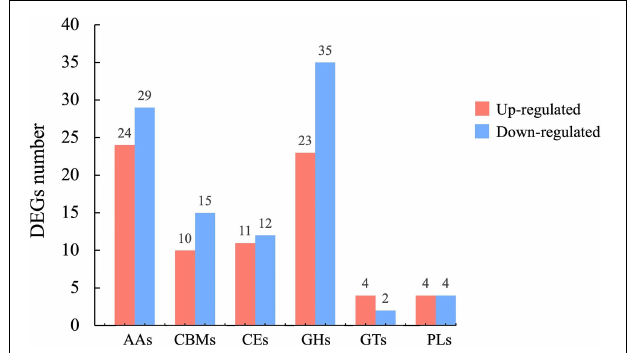
FIGURE 4 | Histogram of upregulated (red bars) and downregulated (blue bars) CAZyme DEGs in newly formed sclerotia.